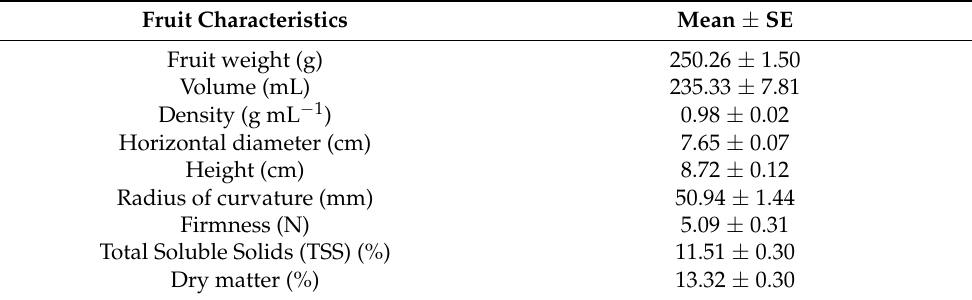
Table 1. Fruit characteristics of ‘Glom Sali’ guava subjected to simulated impact testing. Fruit